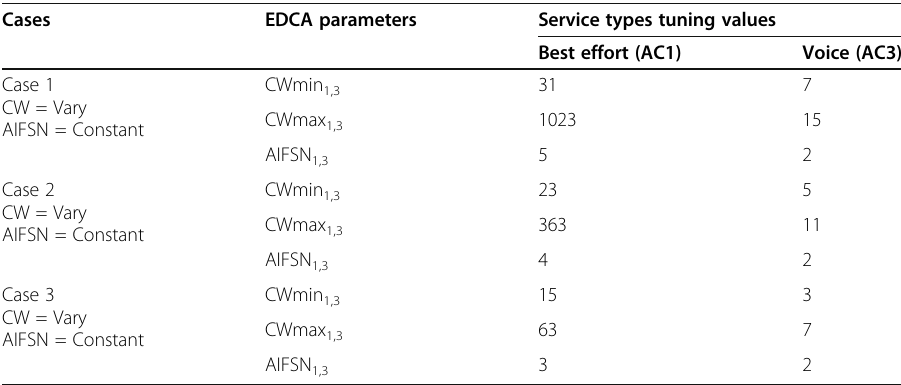
Table 6 The CW tuning numbers at a fixed AIFSN